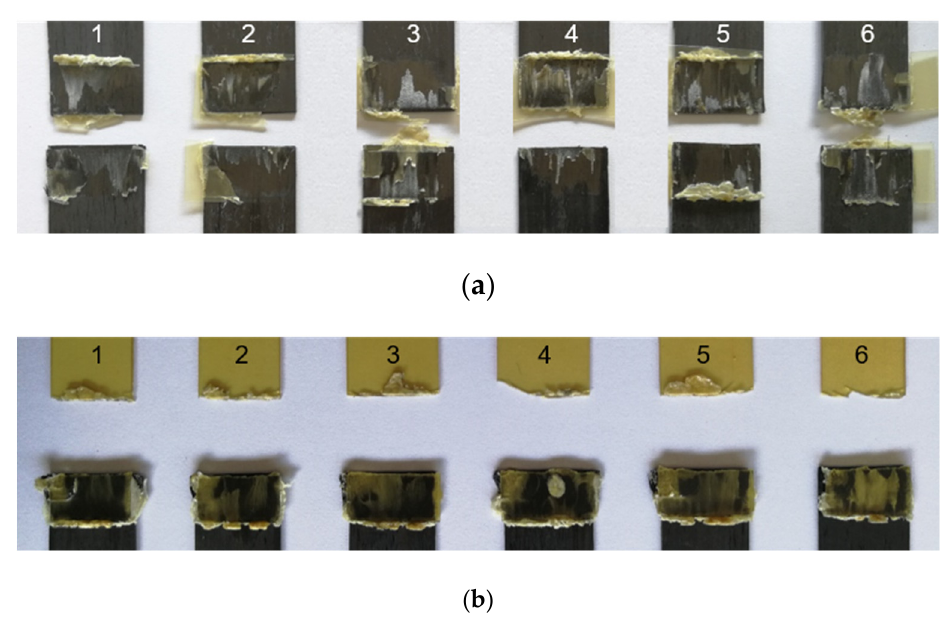
Figure 13. Fracture surfaces after LSS testing of ultrasonically welded specimens from 1 to 6 for ( a ) CF/PEEK on CF/PEEK with 250 µm thick PEI as energy director and ( b ) 2 mm thick PEI on CF/PEEK.